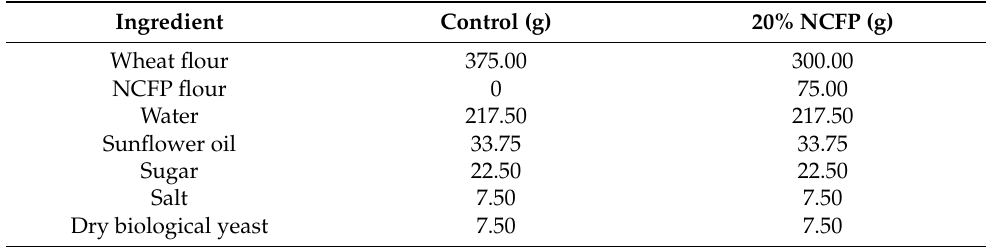
Table 1. Formulations for the preparation of the control bread and NCFP flour-based